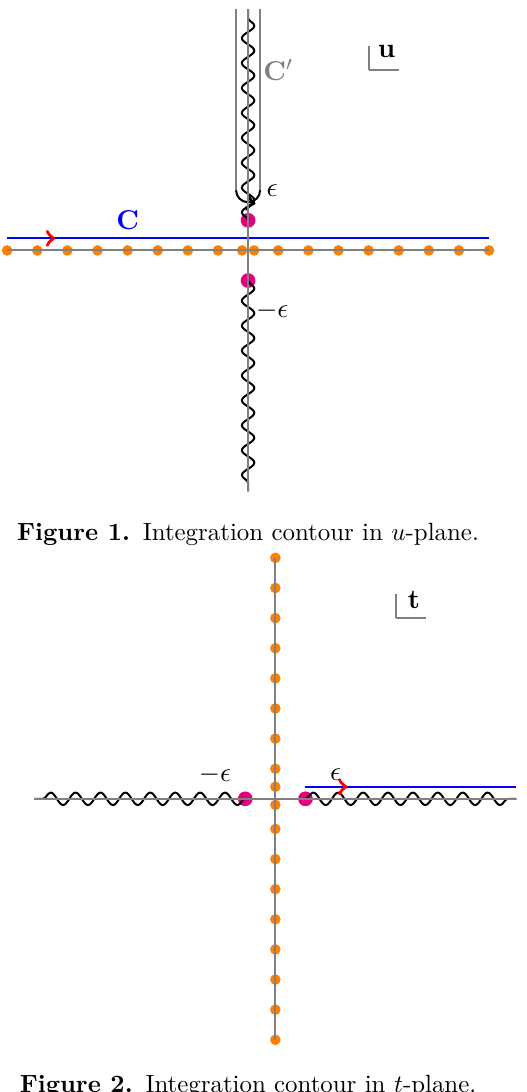
Figure 2. Integration contour in t